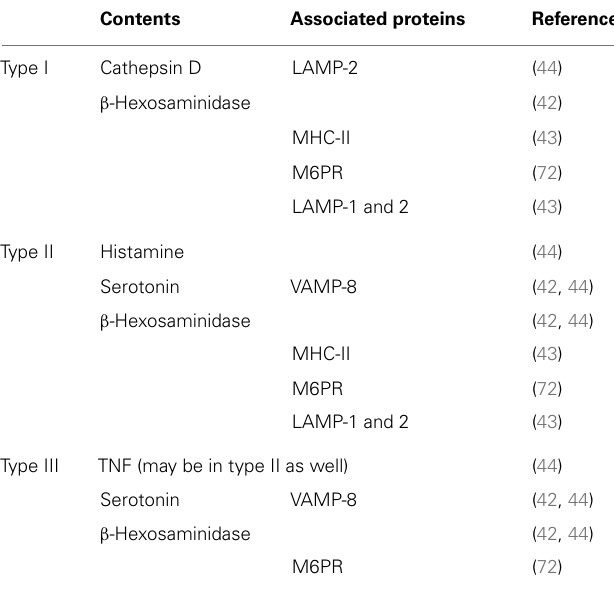
Table 3 | Mast cell secretory granule subsets